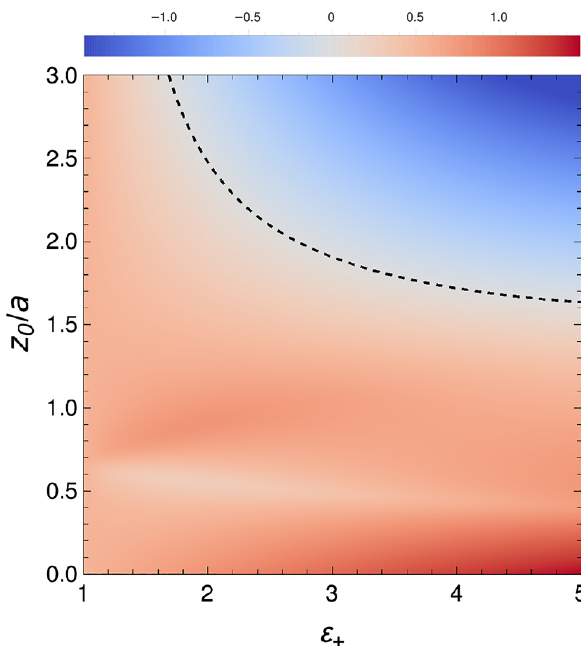
) ( ∕ a in the ( 𝜀 , z )-parameter Figure 3: Density plot of Re d ⊥ − d ∥ + 0 space, computed at the classical quasistatic dipole LSP resonance √ 𝜀 ∕ + 2, of a spherical particle of radius R . The frequency, 𝜔 = 𝜔 ) ( + p = 0, thus separating black dashed line indicates Re d ⊥ − d ∥ regimes with nonclassical 1 ∕ R size-dependent spectral redshifts ) ( > 0] from blueshifts [bluish regions; [reddish regions; Re d ⊥ − d ∥ ) ( = 1 and 𝛾 ∕ 𝜔 = 0 . < 0]. We have assumed: 𝜀 Re d ⊥ − d ∥ d p